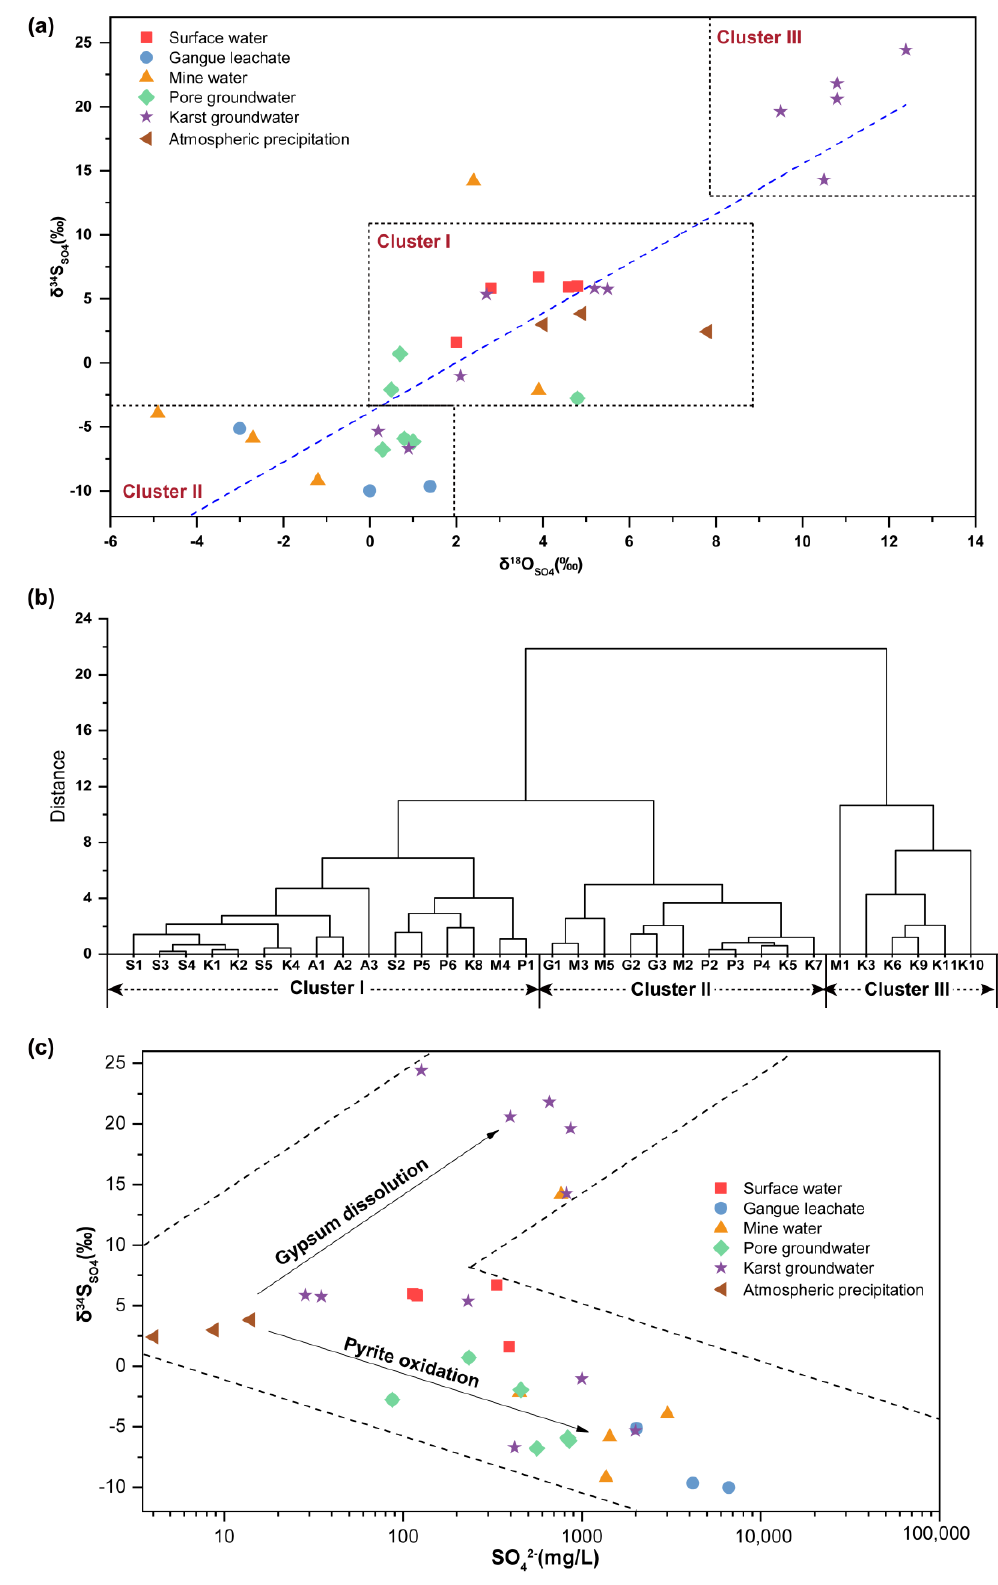
Figure 5. Distribution of δ 34 S SO 4 and δ 18 O SO 4 in different types of water samples ( a ). Clustering of sulfur and oxygen isotopes among samples ( b ). Distribution of SO 4 2 − and δ 34 S SO 4 in water samples indicates the possible source of sulfate ( c